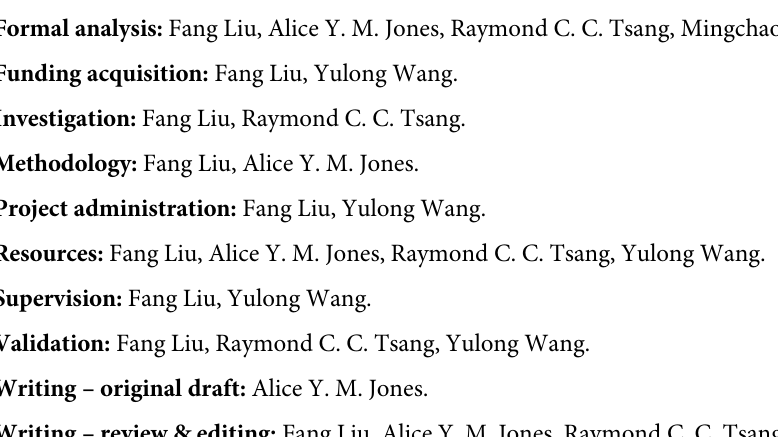
S1 Table. ICC data. S2 Table. Time for each variable returned to baseline. S3 Table. Mean cardiodynamic data. S4 Table. Correlation between 6MWD and cardiodynamic parameters at the end of 6MWT. S5 Table. Comparison of characteristics in subjects with time elapsed since stroke diagno- sis longer or shorter than 1